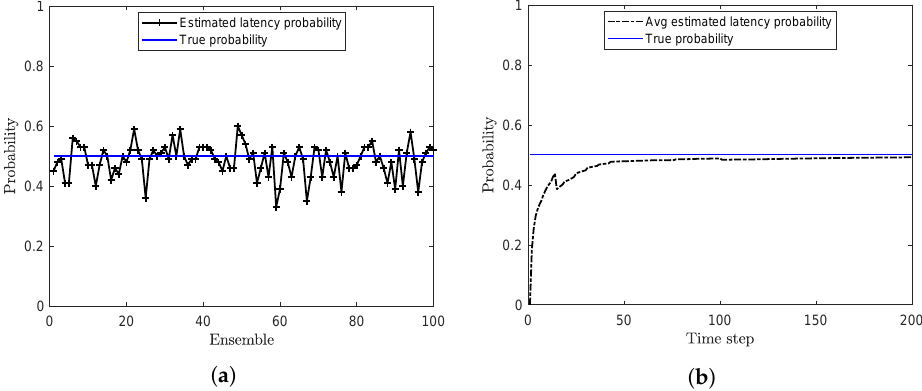
Figure 10. Estimated latency probability ( a ) Offline estimation ( b ) Online estimation (Problem